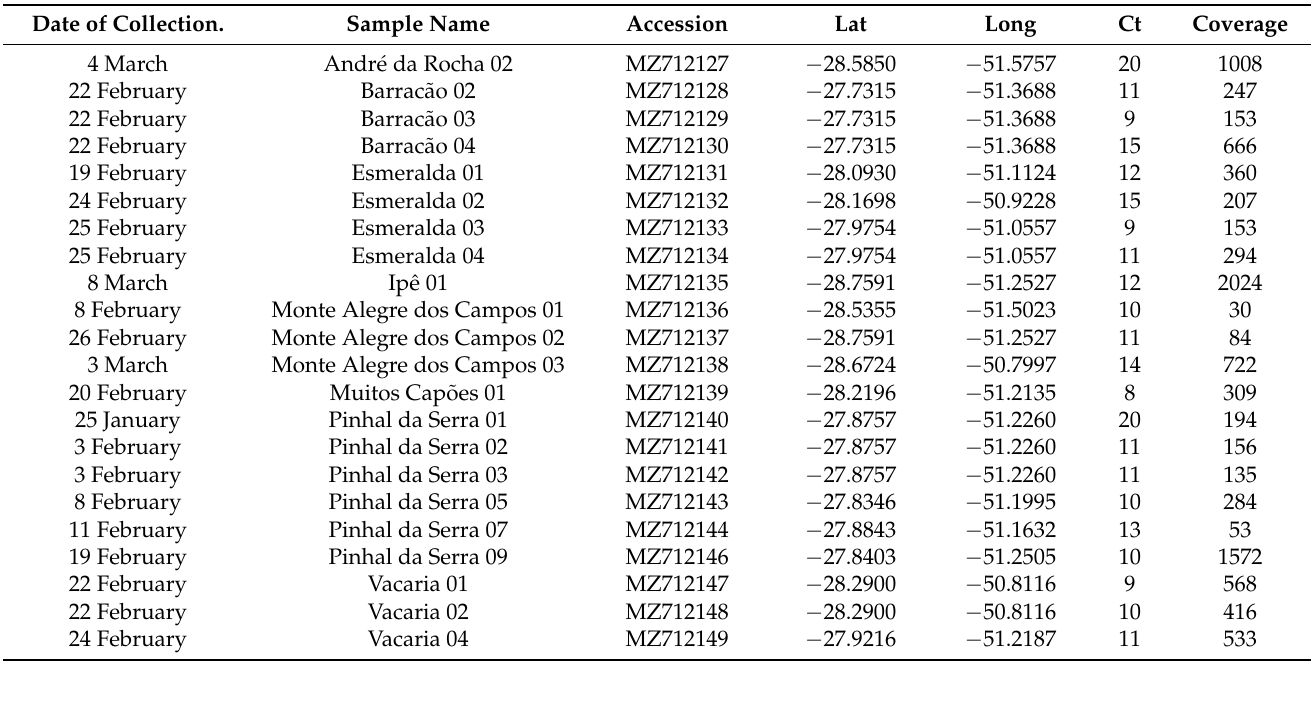
Table 1. List of genomes generated in this study ( n = 22) showing date of collection, sample name, GenBank accession code, latitude, longitude, cycle threshold (Ct), and coverage. All samples were collected in 2021.